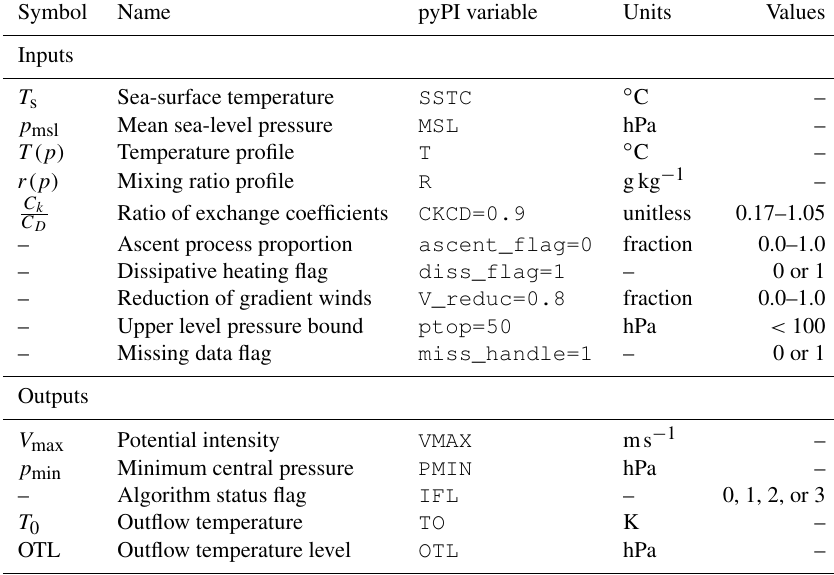
Table 1. Input and output variables and adjustable algorithm parameters for the PI module. Default parameter values are specified in the “pyPI variable” column. Parameters adjusted by the user should never be set outside the “Values” column prescriptions without physical justification and/or appropriate module